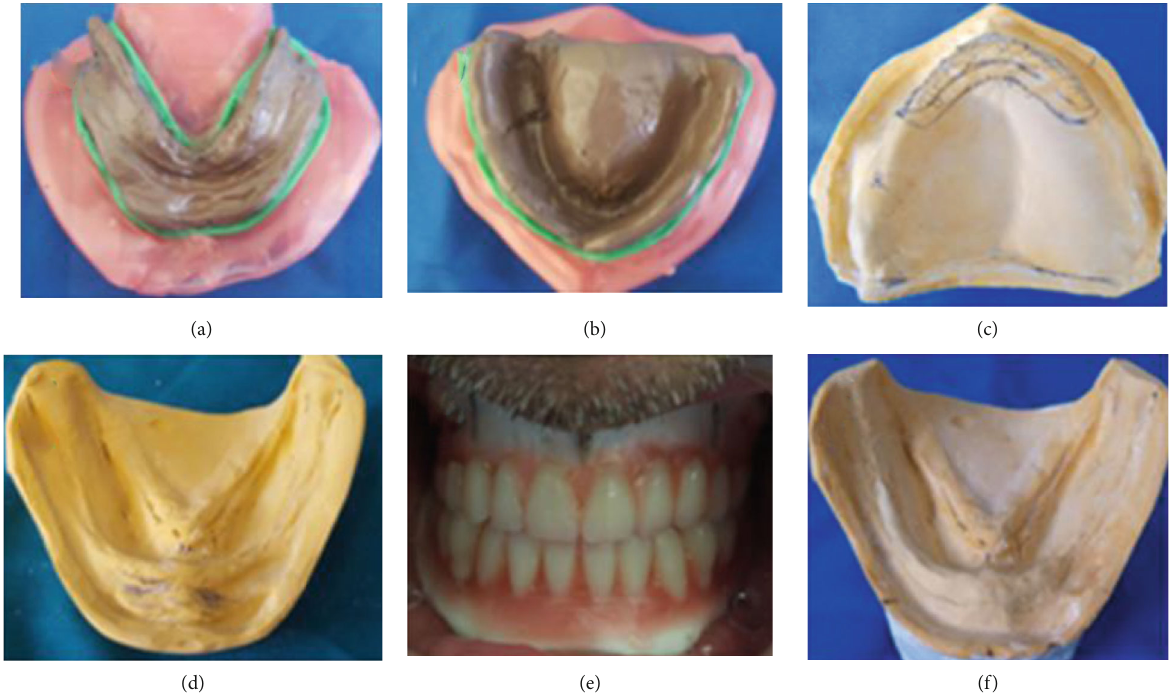
Figure 18: (a, b) Boxing impression. (c, d) The secondary casts. (e) Teeth arrangement try-in. (f) Surgery simulation.